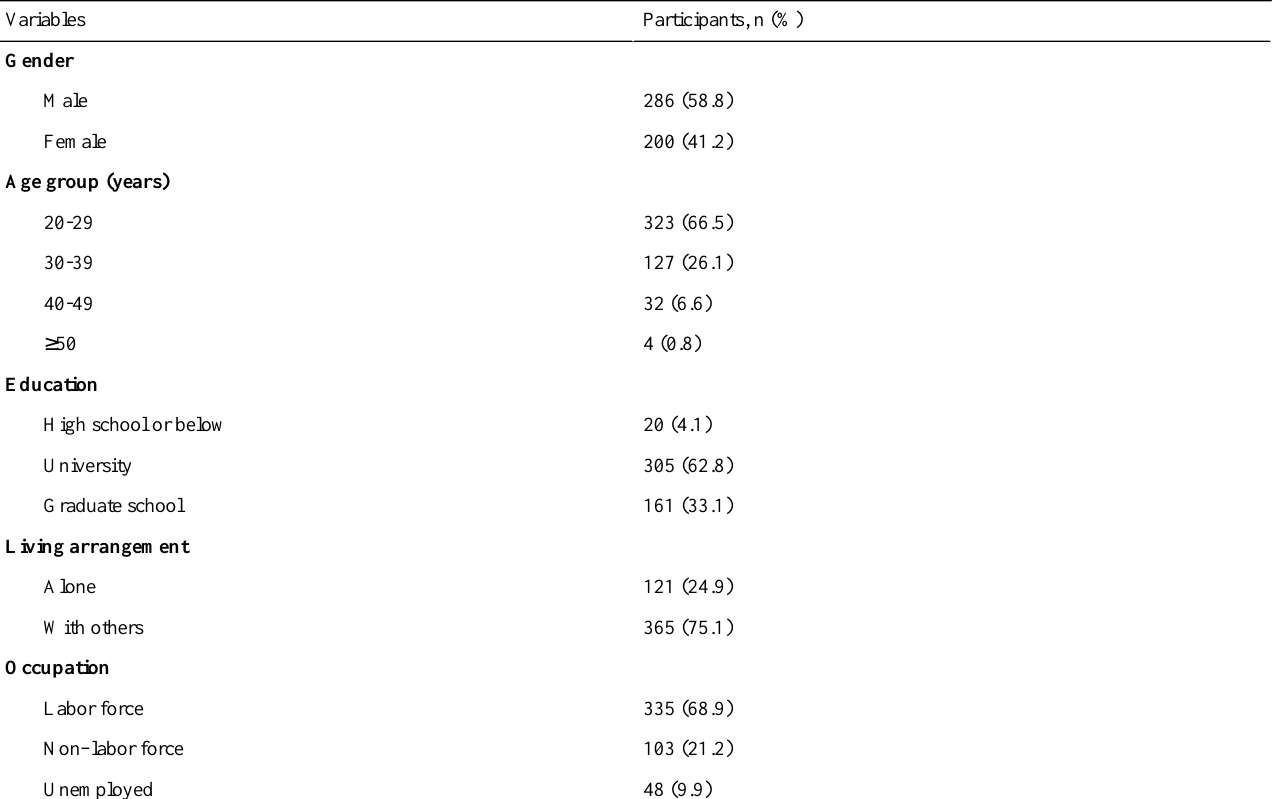
Table 2. Demographic characteristics (N=486).